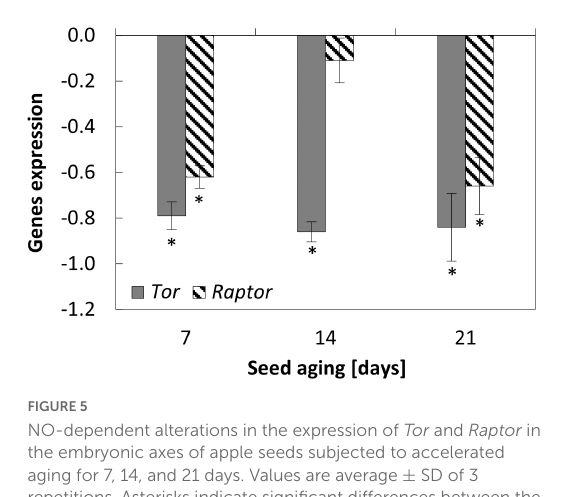
FIGURE4 NO-dependent alterations in the expression of Pimt in the embryonic axes of apple seeds subjected to accelerated aging for 7, 14, and 21 days. Values are average ± SD of 3 repetitions. Asterisks indicate significant differences between the treated sample compared to the control sample, obtained by the Student’s t -test ( P < 0.05).